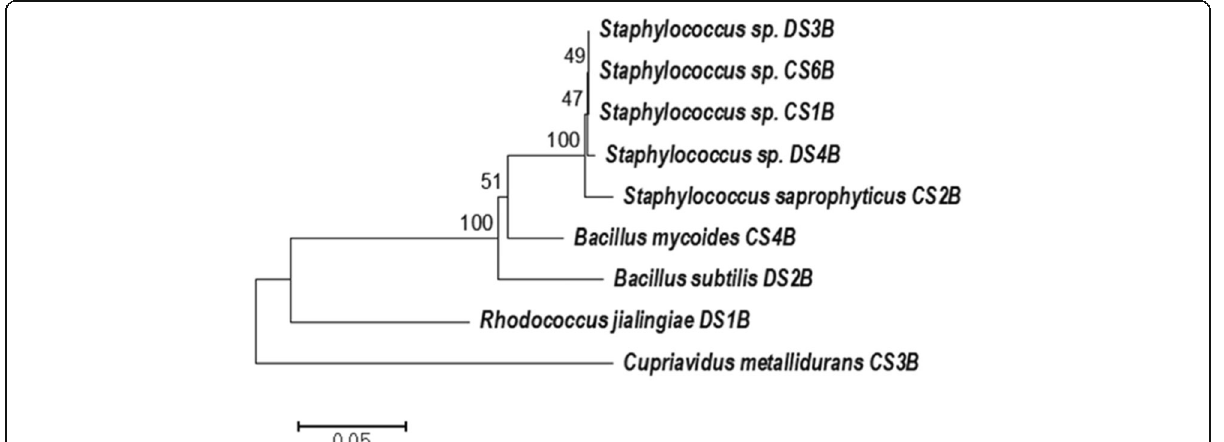
Fig. 1 Phylogenetic tree based on 16S rRNA sequences of endophytic bacteria